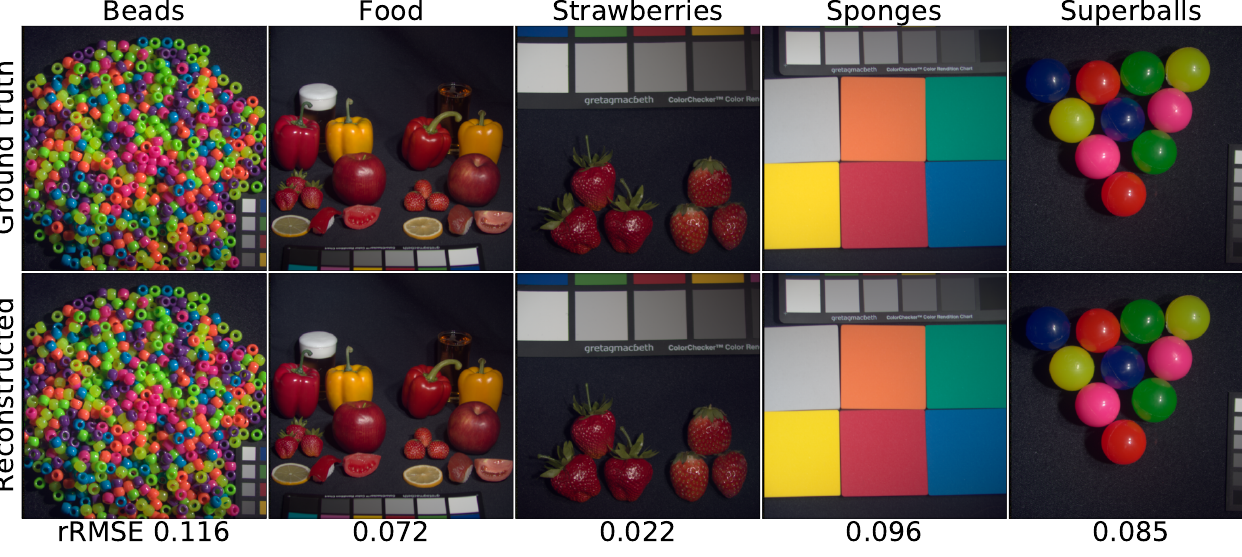
Figure 9. The effects of reconstructing the 5 chosen RGB images from the multispectral